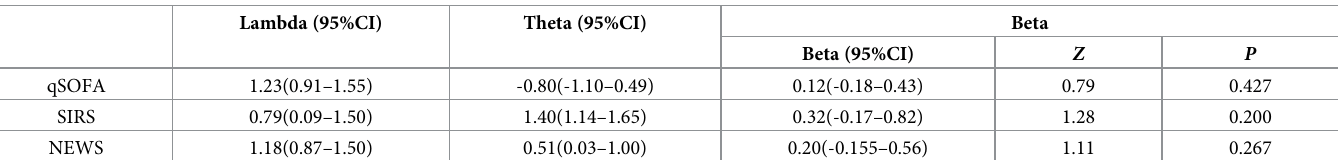
Table 2. The estimated parameters of